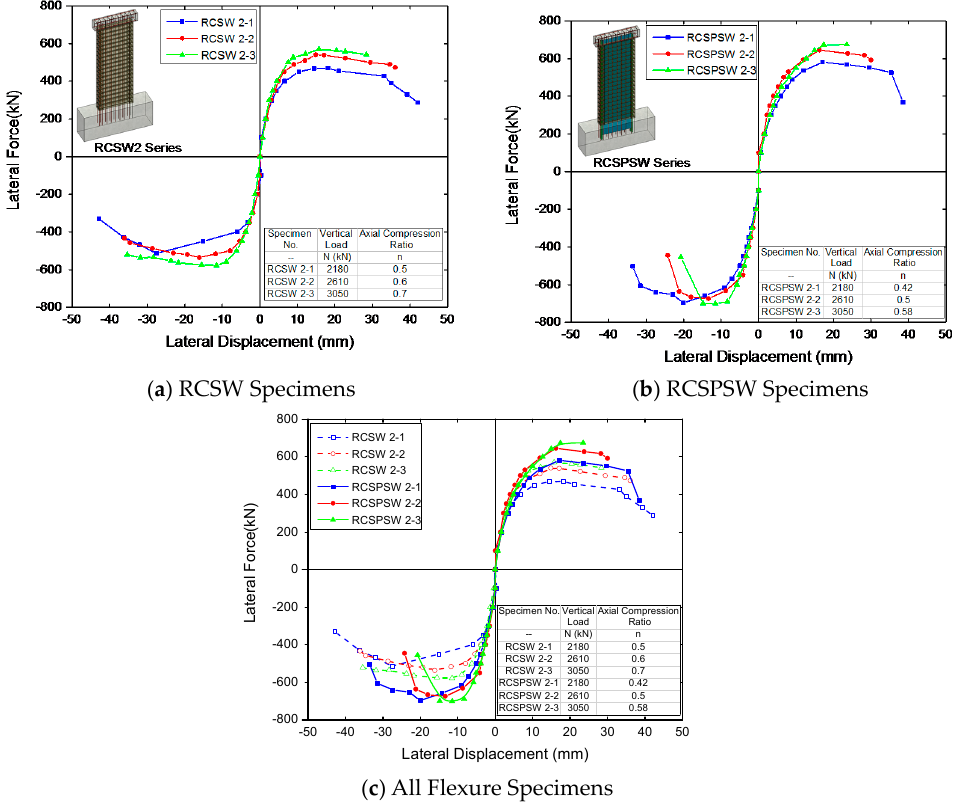
Figure 13. Comparison among the Skeleton Curves for Specimens with Aspect Ratio of 2.7 ( a ) RCSW Specimens; ( b ) RCSPSW Specimens; and, ( c ) All Flexure Specimens.